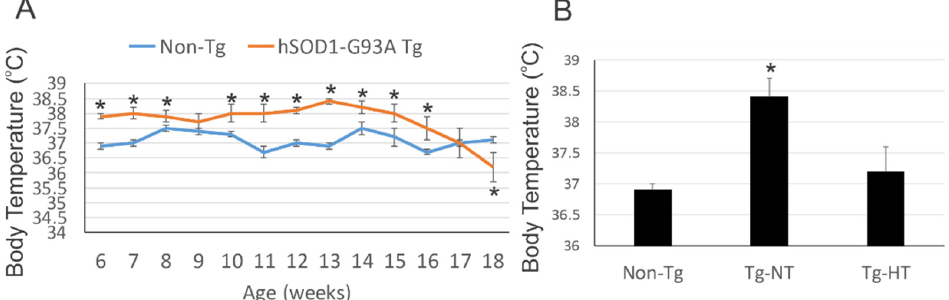
Figure 1. Compared to non-tg mice, male hSOD1-G93A tg mice have elevated body temperatures that can be adjusted by environmental temperature management using cold acclimation. ( A ) Male hSOD1-G93A tg mice ( n = 25) had significantly (* p < 0.05) increased body temperatures throughout their disease course compared to their male age-matched non-tg littermates. ( B ) Whole-body hypothermia (HT) was induced by housing hSOD1-G93A tg mice in a cooling chamber (12 h in/12 h out, every 24 h). Non-cooled, normothermic (NT) hSOD1-G93A tg mice were maintained at ambient room temperature. At 10 weeks of age (shown here) and thereafter, longitudinal intermittent mild whole-body cooling significantly (* p < 0.05) reset body temperature in hSOD1-G93A tg mice (Tg-HT) by 1–2 ◦ C compared to NT hSOD1-G93A tg mice (Tg-NT). Non-tg mice were consistently near 36.8 ◦